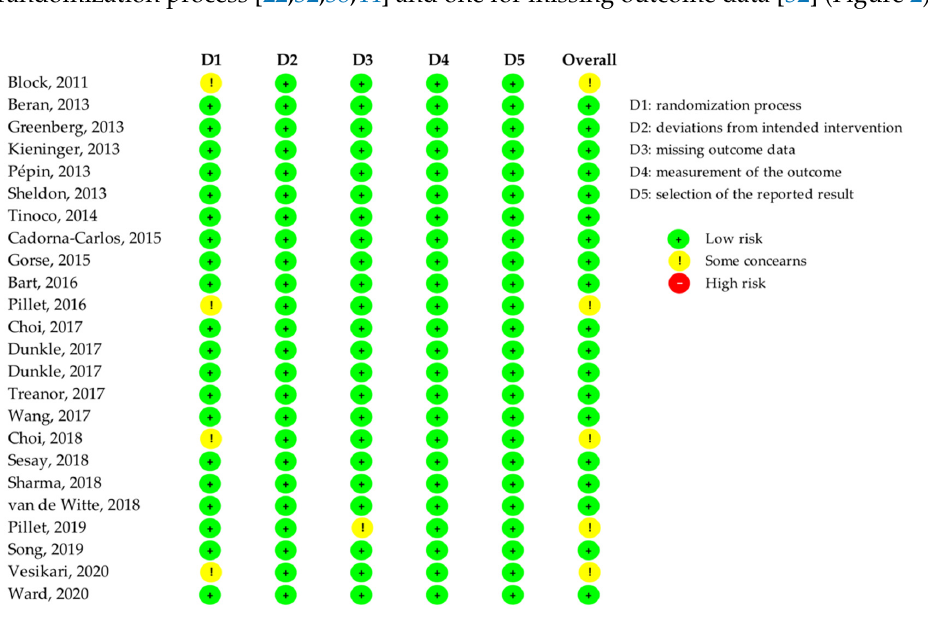
Figure 2. Risk of bias of included